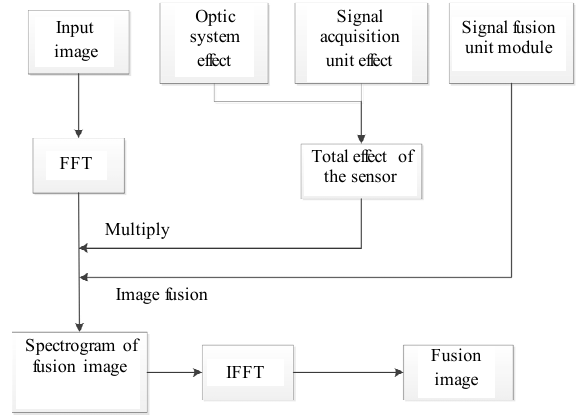
Fig. 5 Simulation flow of the sensor